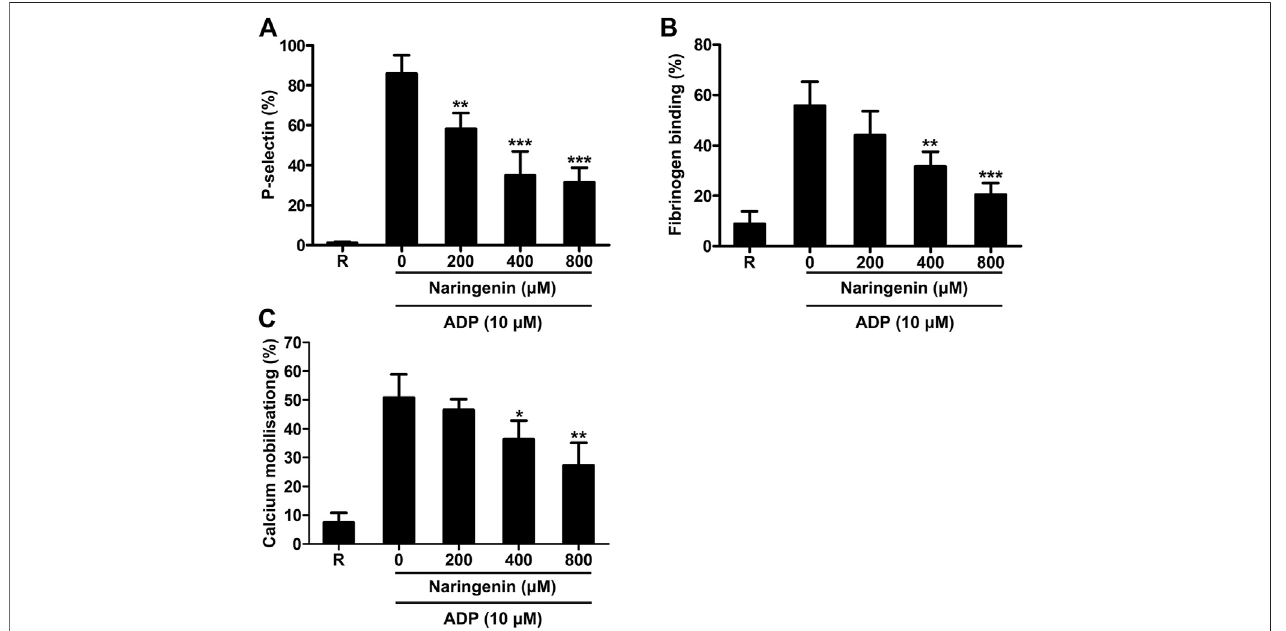
FIGURE2| Naringenininhibitsplateletgranulesecretion,integrininside-outsignalingandcalciummobilization.TheeffectsofnaringeninonP-selectinexposure (A) and fi brinogen binding (B) upon stimulation with ADP (10 μ mol/L) were determined in washed platelets. Fluo-3 AM dye-labeled washed platelets were stimulated with ADP (10 μ mol/L) in the absence or presence of different concentrations of naringenin, and the intracellular calcium levels were detected by fl ow cytometry (C) . R represents the levels of P-selectin, fi brinogen binding or calcium mobilization in resting platelets. Data are expressed as means ± SD ( n (cid:2) 3). * p < 0.05, ** p < 0.01, *** p < 0.001 compared with the vehicle control